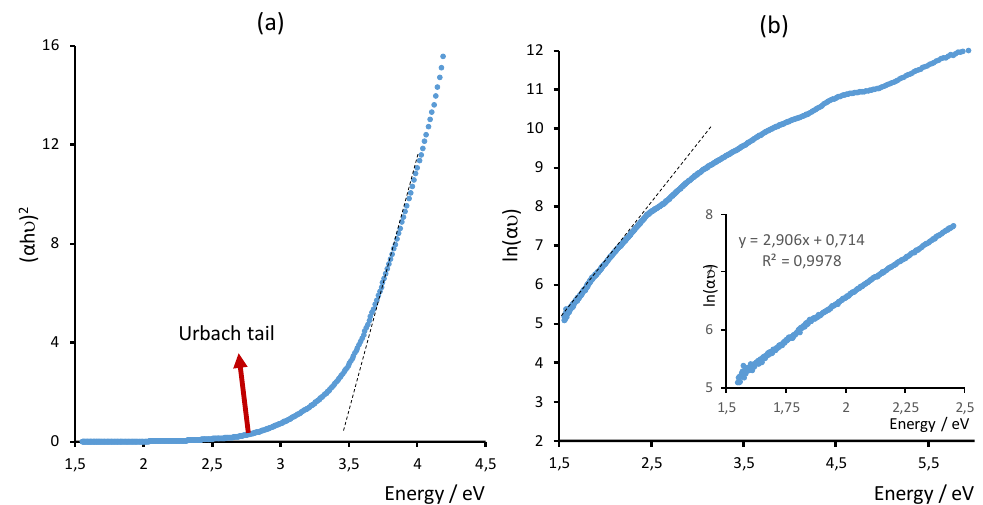
Figure 5. ( a ) Tauc plots for estimation of the TCDs bandgap and ( b ) Urbach energy estimation for GCDs.